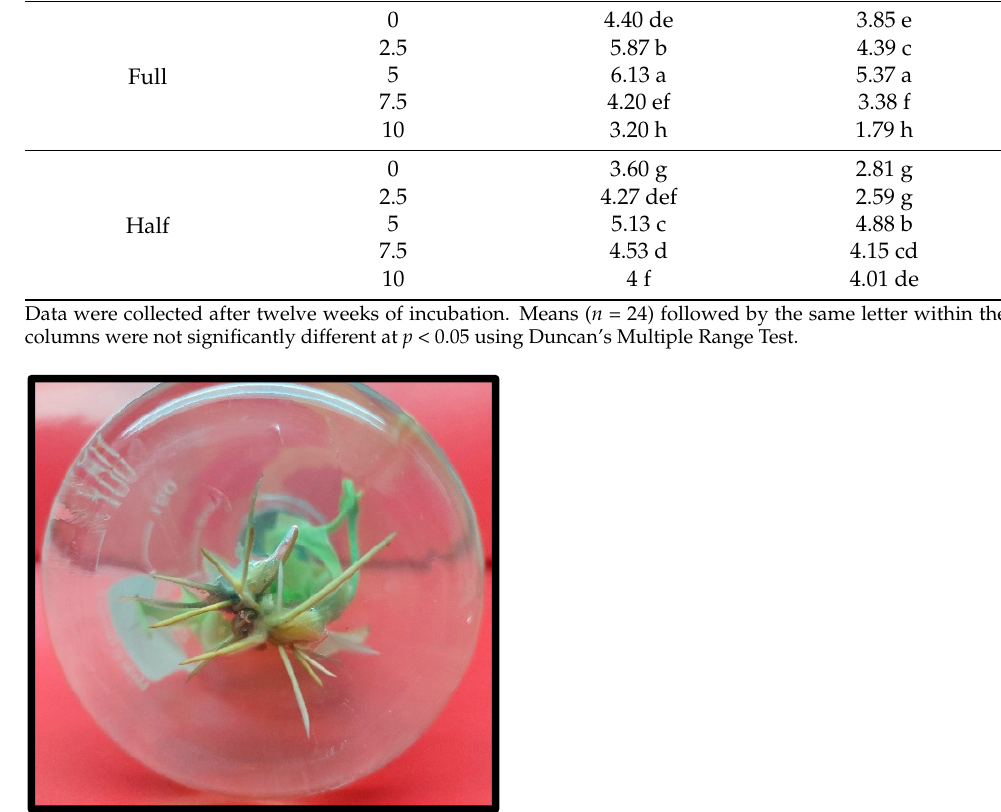
Table 4. Effect of MSB5 medium strength and IAA on root induction of C. caesia plantlets. Strength IAA ( μ M) Number of Roots Length of Roots (cm) 0 Full